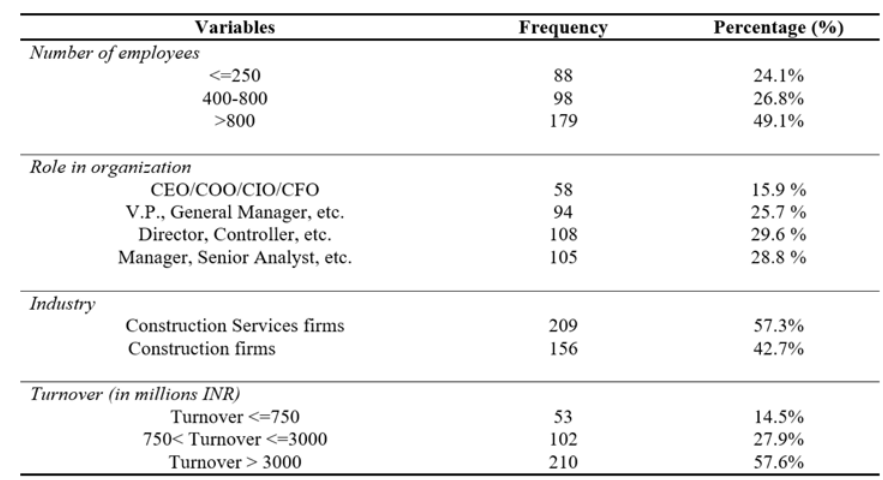
Sample Characteristics (N=